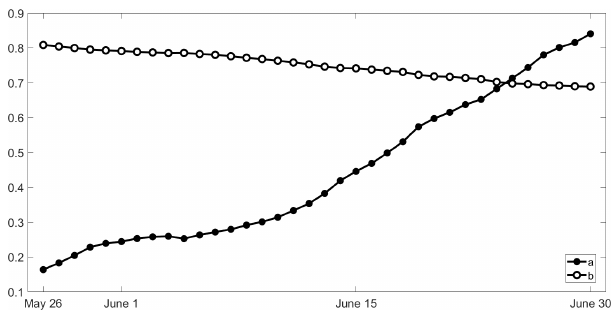
Figure 3. Temporal evolution of coefficients a and b of the normal model with two covariates.